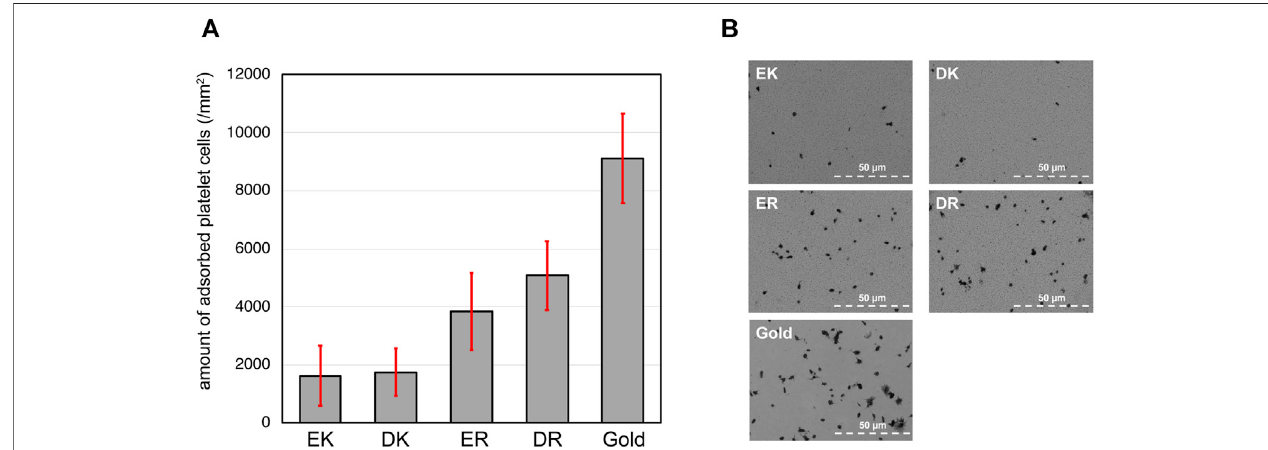
FIGURE 3 | (A) The density of adhered platelet cells on peptide-SAMs and gold surface. Error bars denote standard deviation (n (cid:2) 45). (B) Representative SEM images of the adhered platelet cells on the peptide-SAMs and the gold surface. Note that the particles smaller than the platelets are gold clusters formed after the deposition of gold to enhance the conductivity for SEM imaging.